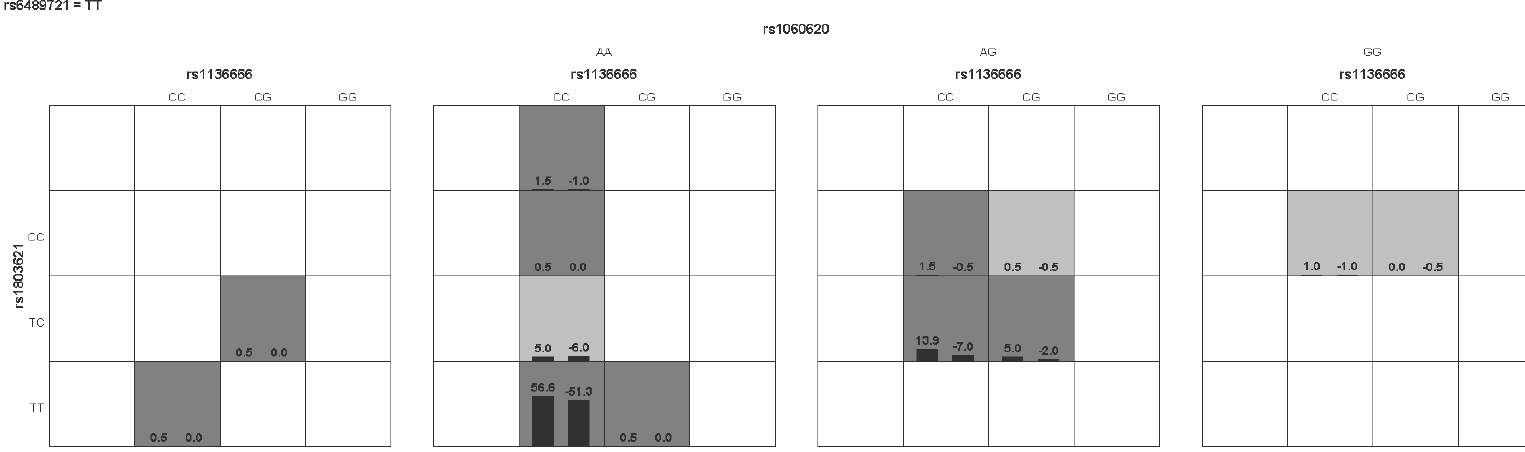
Figure 3. Interactions among the four SNPs. The dark and light gray boxes represent high and low risk factor combinations, respectively. The left bars within each box represent cases and the right bars represent controls. The heights of the bars are proportional to the sum of samples in each group.